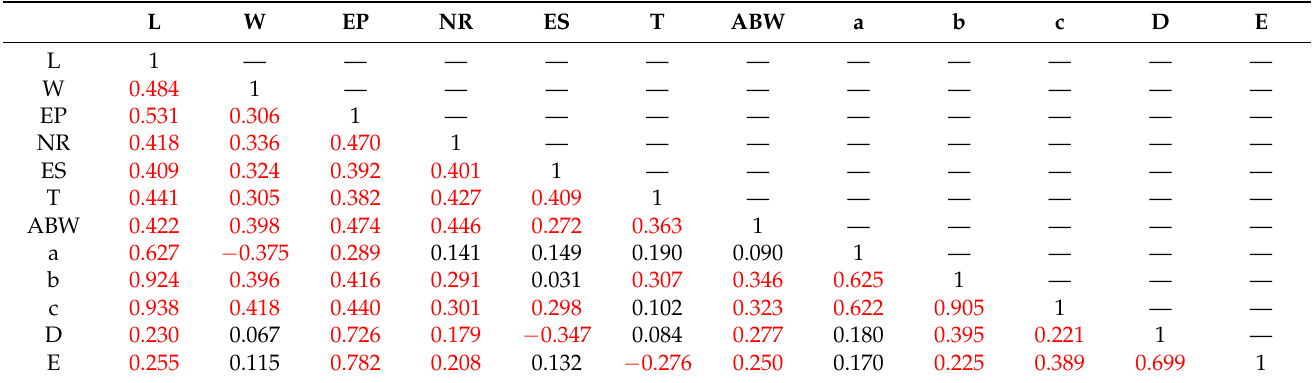
Table 6. Correlation coefficients among morphometric traits of S. feltiae infective juveniles for all isolates. All coefficients that are statistically significant ( p < 0.05) are marked in red.